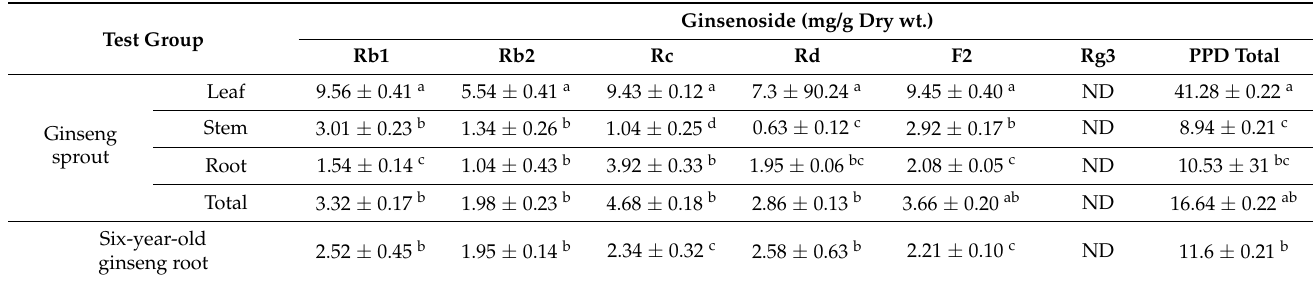
Ginsenoside (mg/g Dry wt.)